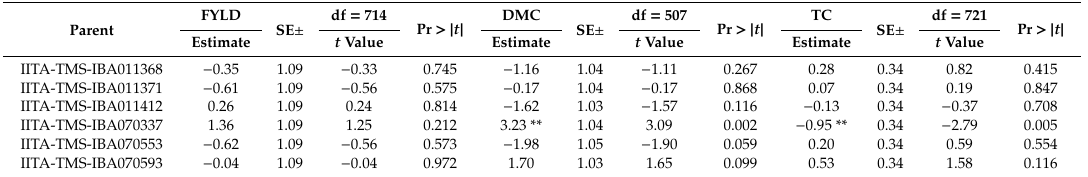
Table 5. Estimates of parental general combining ability e ff ects for fresh yield, dry matter content, and total